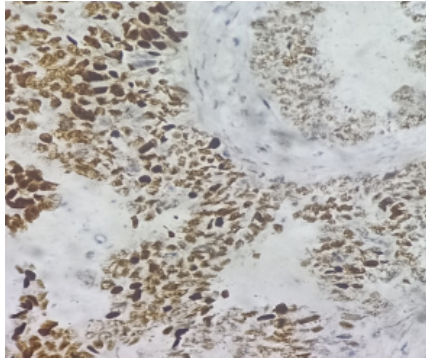
Figure 1. Photomicrograph of P53 immunohistochemical stain negativity (40x view)